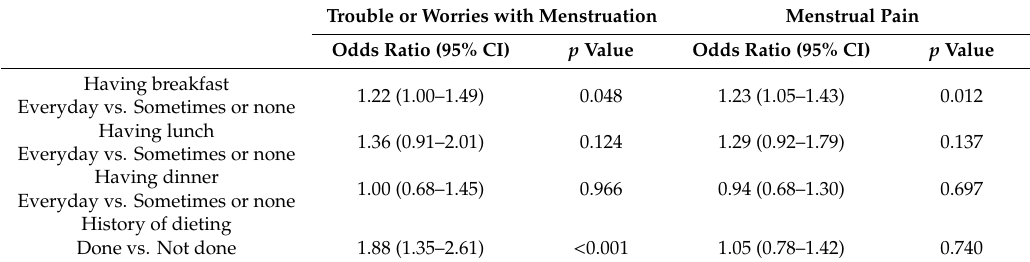
Table 2. Risks for menstrual problems related to dietary habits and dieting history. Trouble or Worries with Menstruation Menstrual